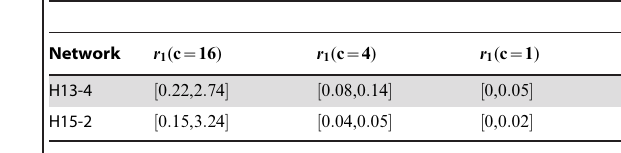
Table 4. The detailed parameters a for three different resolutions r 1 , r 2 , and r 3 of the communities detected in the benchmark hierarchical networks H13-4 and H15-2, where c is the number of discovered